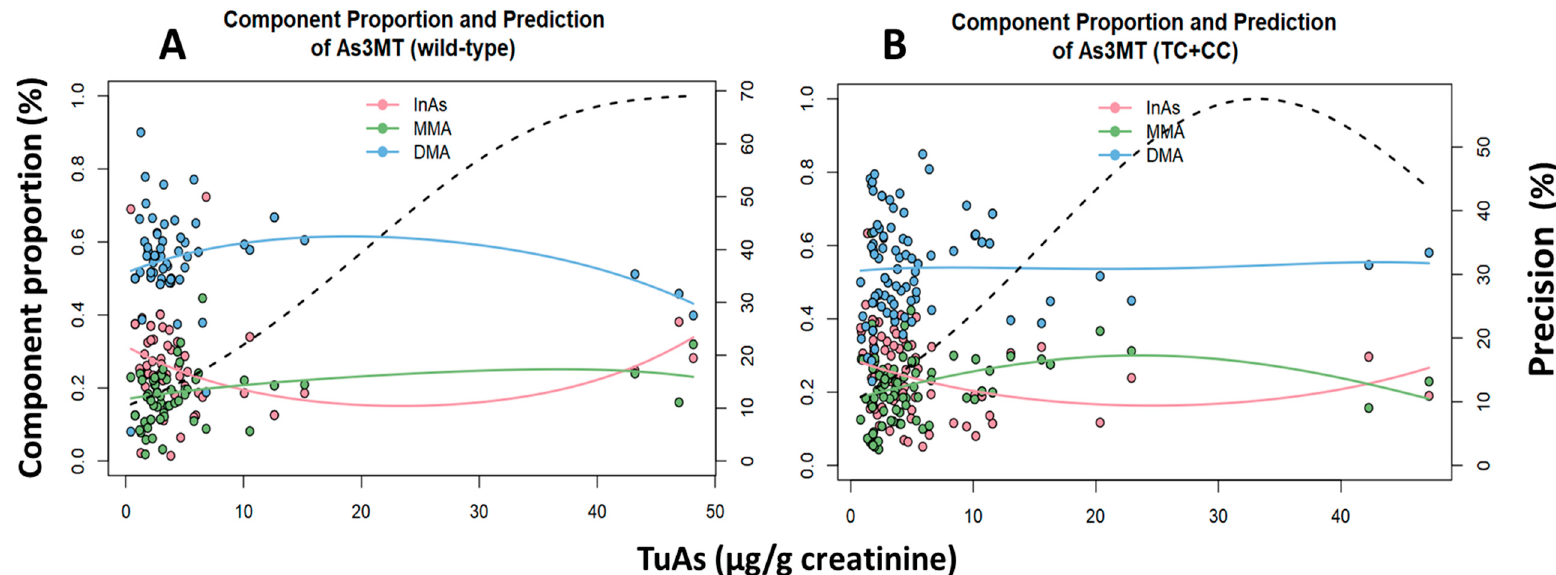
Figure 4. Multivariate Dirichlet regression on the relationship among the urinary arsenic metabolites and urinary As concentration by genotype adjusted. ( A ) Wild-type genotype of As3MT ; InAs ( p = 0.18), MMA ( p < 0.01), DMA ( p < 0.01). ( B ) Heterozygous + homozygous genotypes of As3MT : InAs ( p = 0.70), MMA ( p = 0.06), DMA ( p = 0.08).